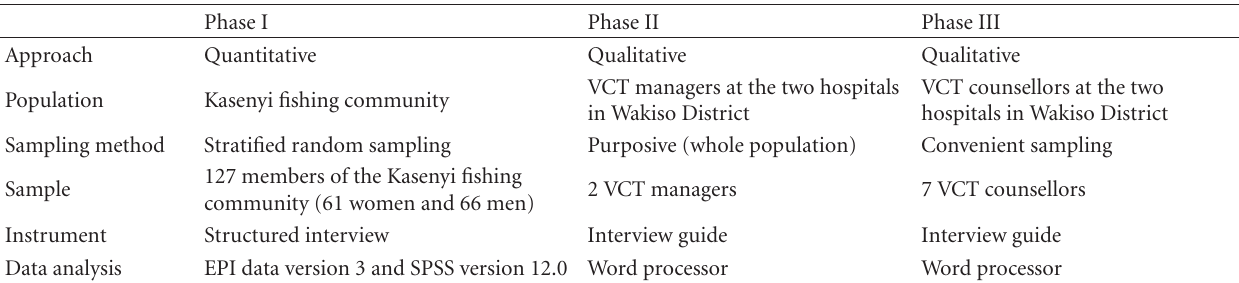
Table 1: Phases of the